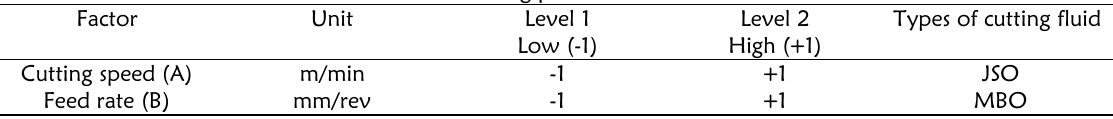
Figure 3: Schematic diagram of the oil in water mixture Table 3: Cutting parameters and